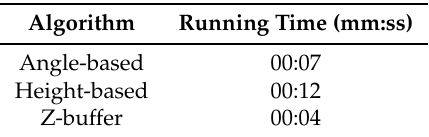
Table 3. Running times of the Z-buffer, height-based, and angle-based algorithms for occlusion detection using a single perspective